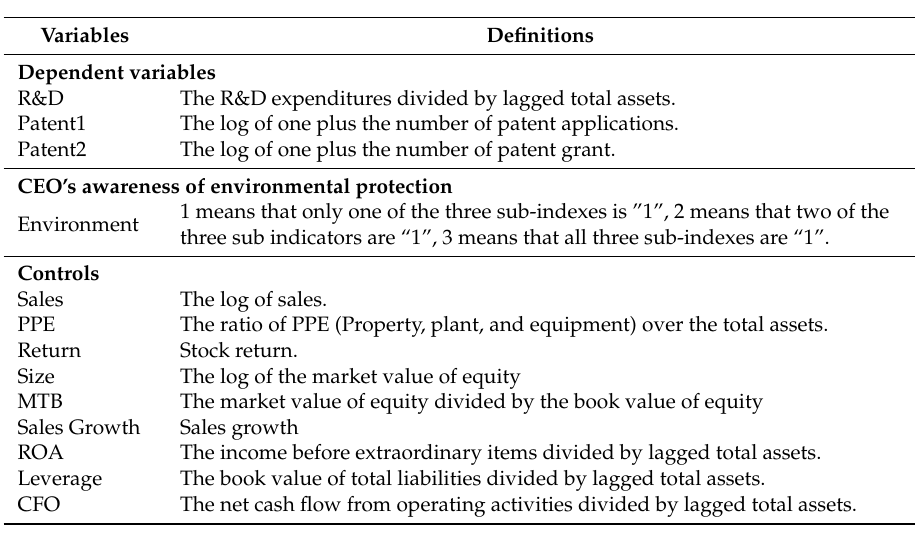
Table 1. Variable